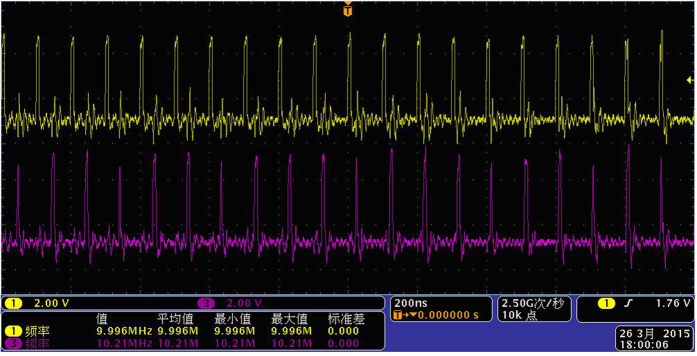
The same frequency pulse of f1 and f2.